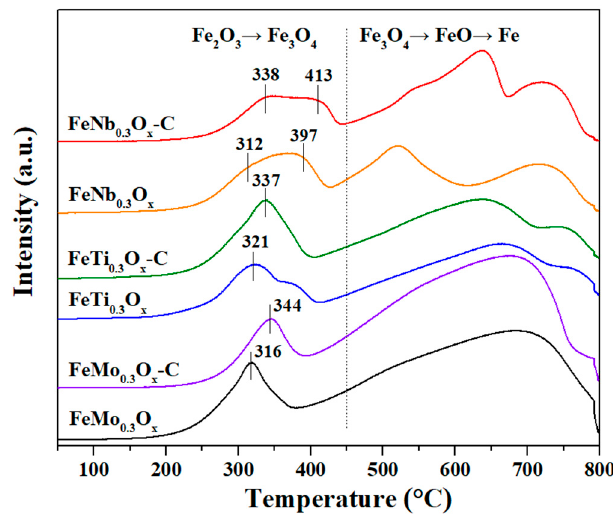
Figure 6. H 2 -TPR results of all the FeM 0.3 O x -C and FeM 0.3 O x (M = Nb, Ti, Mo) samples in a flow of 10 vol % H 2 /N 2 with the heating rate of 10 °C min − 1 . Before measurement, the sample was pretreated in N 2 at 300 °C for 1 h, and purged by N 2 for 0.5 h.